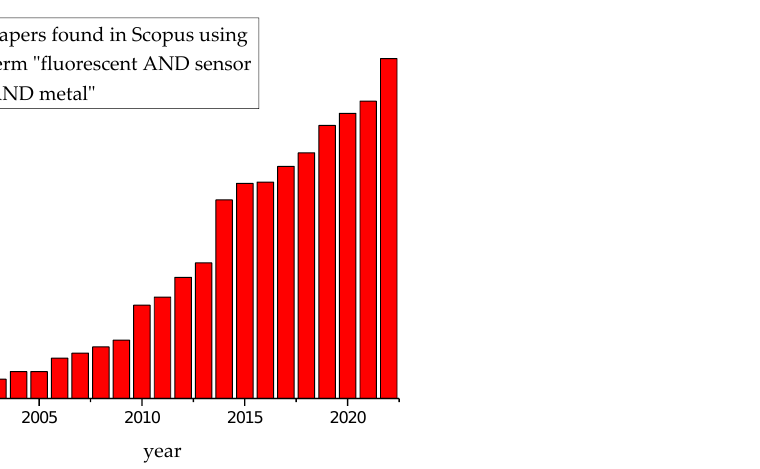
Figure 1. Quantity of papers devoted to fluorescent sensors of metals published per annum. Papers found in Scopus using the search term ‘fluorescent AND sensor AND metal’.